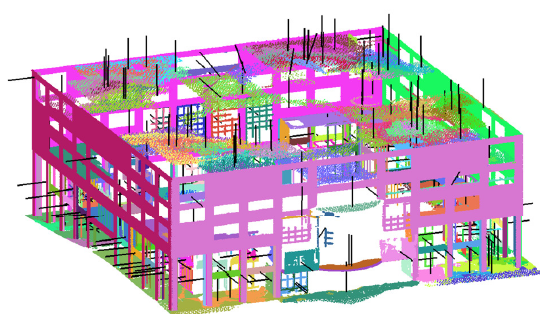
Figure 8. Selected reference planes from the “City hall” TLS/ALS data and computed plane normals. Colors refer to different planes.